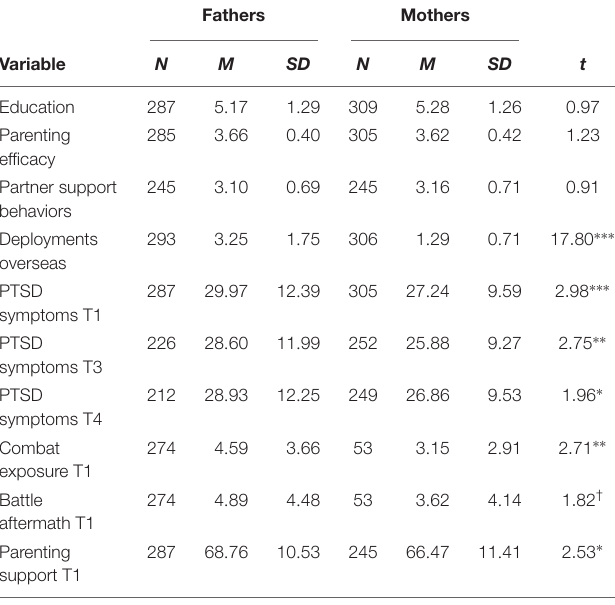
TABLE 1 | Means, standard deviations, N s, and mean comparisons for study variables.